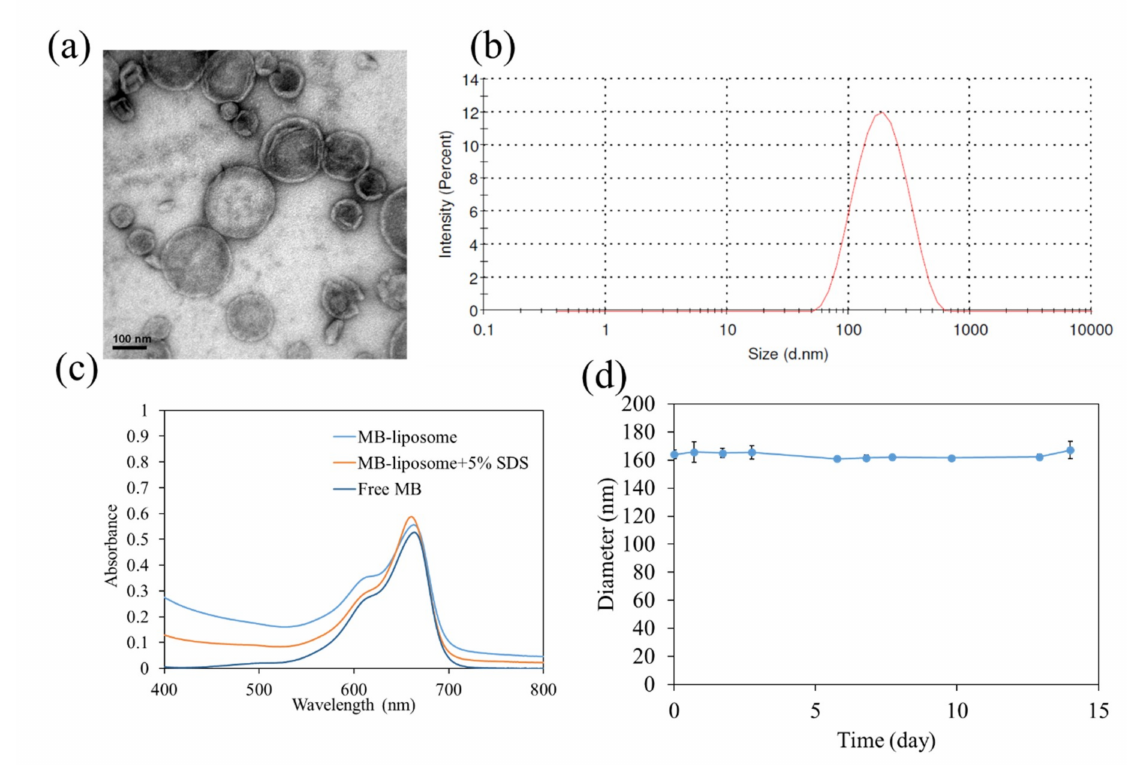
Figure 2. ( a ) The TEM image of Methylene blue (MB)-liposomes.; ( b ) Dynamic light scattering (DLS) measurement of MB-liposomes.; ( c ) UV–Vis spectra of free MB, MB-liposomes, and MB-liposomes with 5% sodium dodecyl sulfate (SDS).; ( d ) hydrodynamic diameter of MB-liposomes over 14